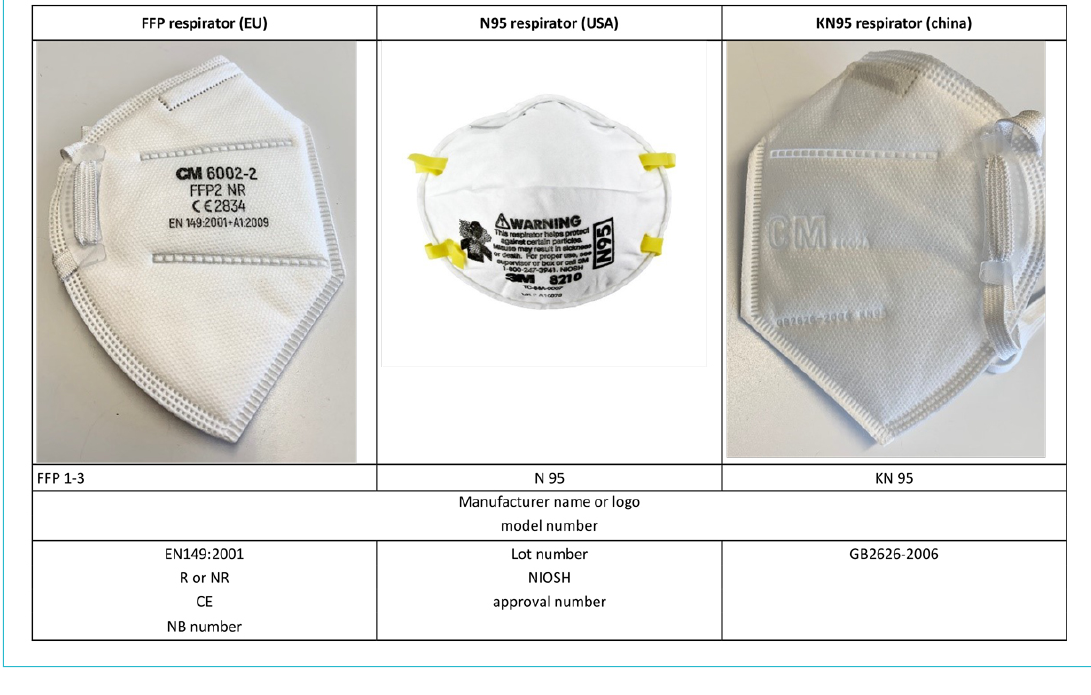
Figure 1: Standard markings printed on FFP respirator. Examples with certifications from Europe (left), the United States of America (centre) and China (right).EU = European Union; FFP = filtering facepiece; NB = notified body; NR = non reusable; R = reusable; USA = United States of America.